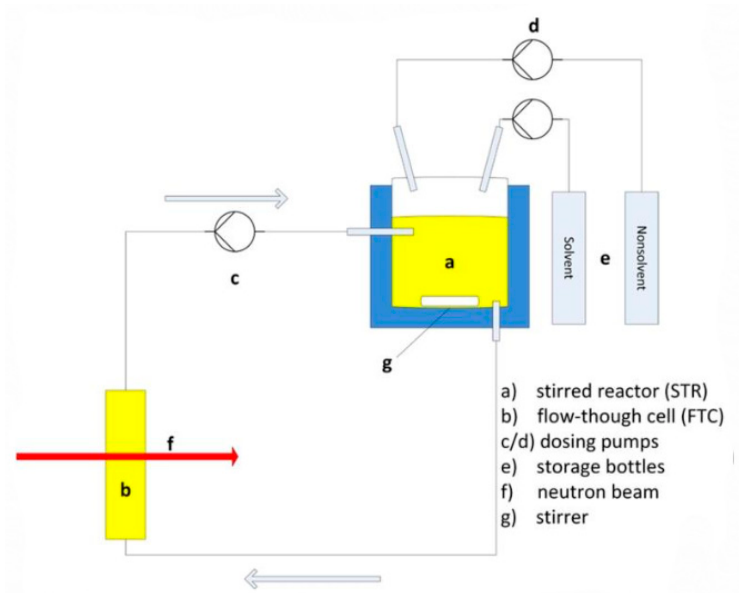
Figure 2. A flow-through cell used to study the liquid-liquid demixing process, which is the preliminary stage before casting the material to form a porous membrane. The degree of phase separation and the composition of the different phases determines the membrane structure to a large degree. The stirred reaction vessel is connected to the measuring cell, and the reacting mixture can be pumped through the neutron beam (reproduced with permission from [15], AIP Publishing, 2017).